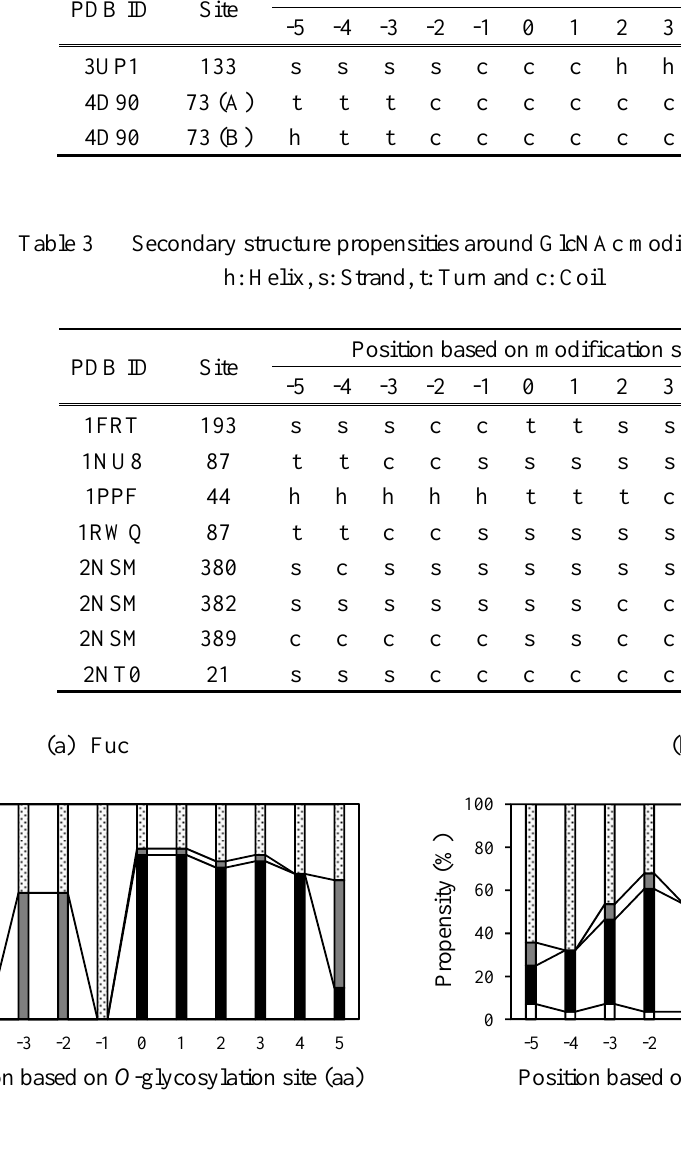
Fig. 1 Secondary structure propensities around Fuc (a) and Man (b) modification sites. White bar: helix structure (H, G, I), black bar: strand structure (E, B), gray bar: turn structure (T), dotted bar: coil structure (S, C). Many Fuc modifications were found in EGF-like domains (Rao et al., 1995; Tan et al., 2002; Rana et al., 2011; Schurpf et al., 2012). Most Fuc modification sites in EGF-like domain were modified on the edge of b -strand structures, and secondary structures of O -glycosylation sites were kept in the same position. No helix structures appeared around Fuc modification sites. Man modification sites were identified in b -strand and coil regions (Figure 1b). In a previous study, Man modification sites existed on b -strand structure in cadherins and plexins (Vester-Christensen et al., 2013). Twenty-seven of Man modification sites were found in Cadherin-1 and Cadherin-2 proteins in this study, but seven sites of 27 were contained in coil region. The results suggest that Man modification prefers to modify in b -strand or coil